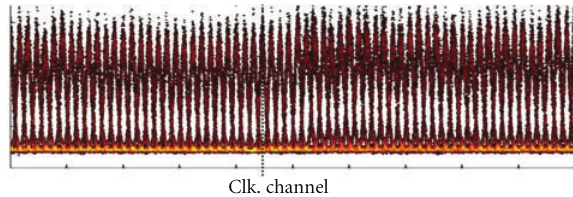
Figure 18: 650Gbit/s channel identification and simultaneous clock recovery by adding a small spectral feature to one TDM channel